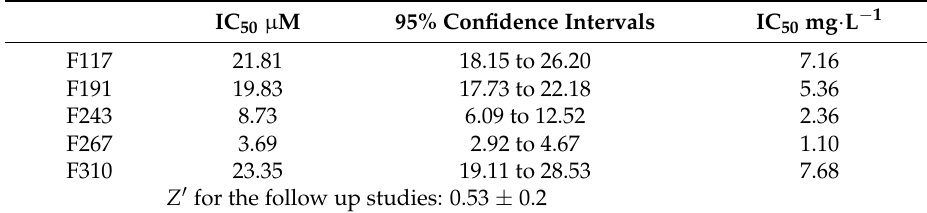
Table 1. Potency values (IC 50 ) of the five identified lead